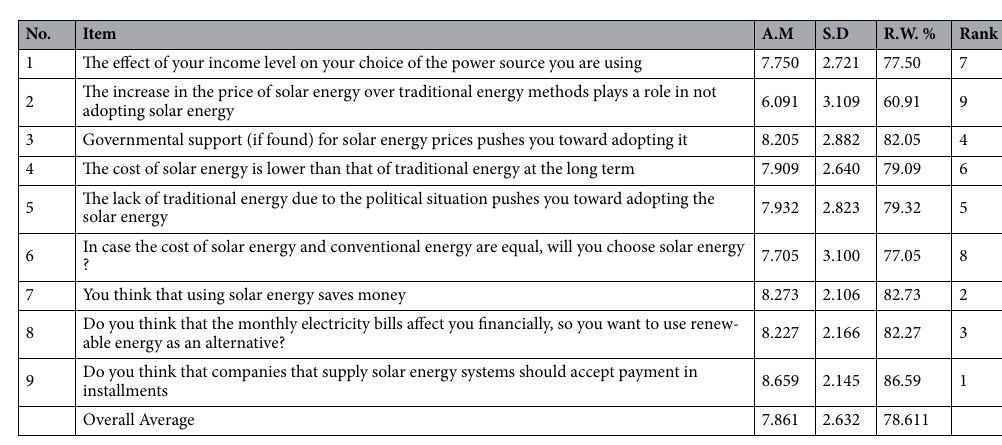
Table 3. Impact of the finical situation on making decision to use solar energy at home.